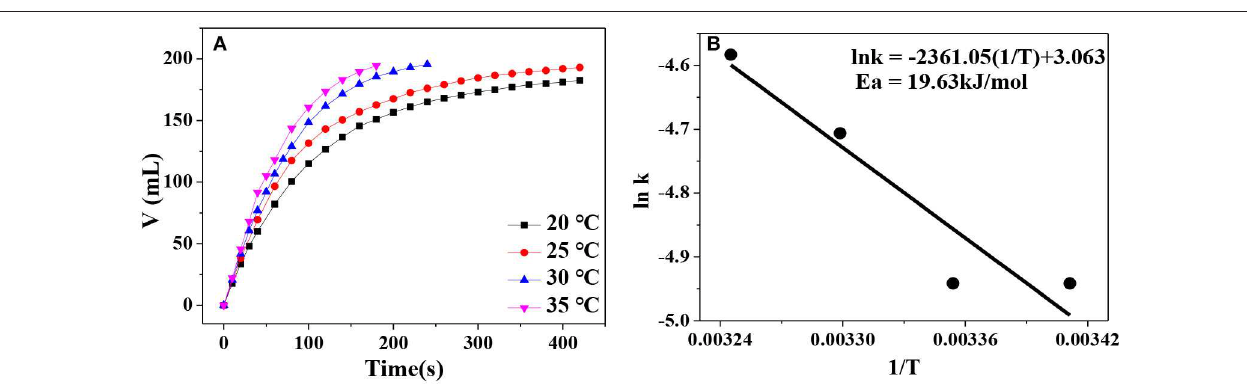
FIGURE 8 | (A) Hydrogen evolution at various catalytic temperature in the range of 20–35 ◦ C; (B) the relationship between logarithm of k and 1/T.